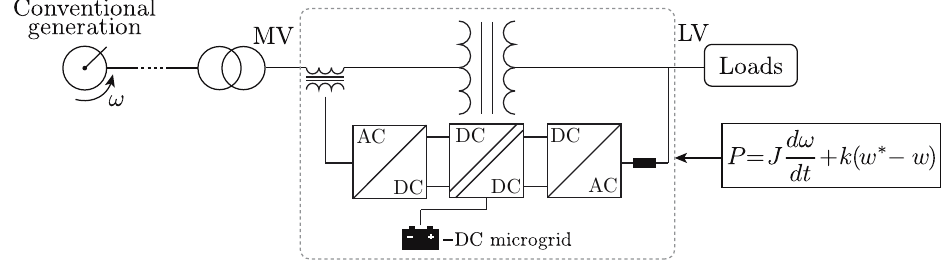
Figure 22. HDT with virtual